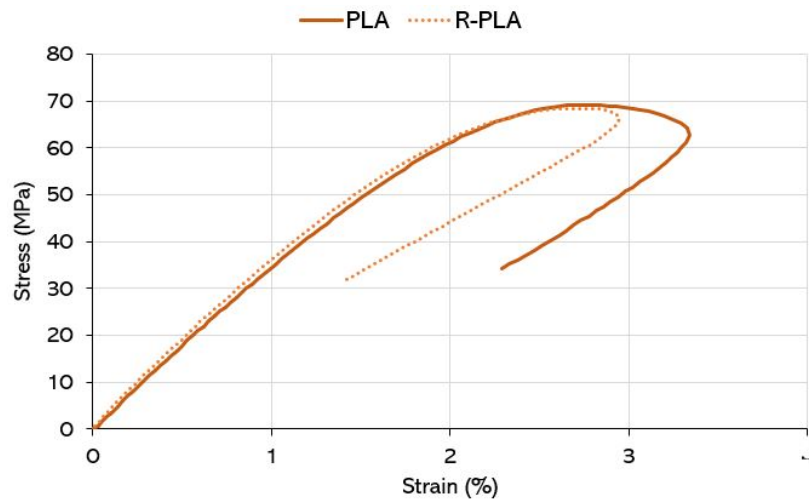
Figure 3. Stress/strain curves for PLA and R-PLA.